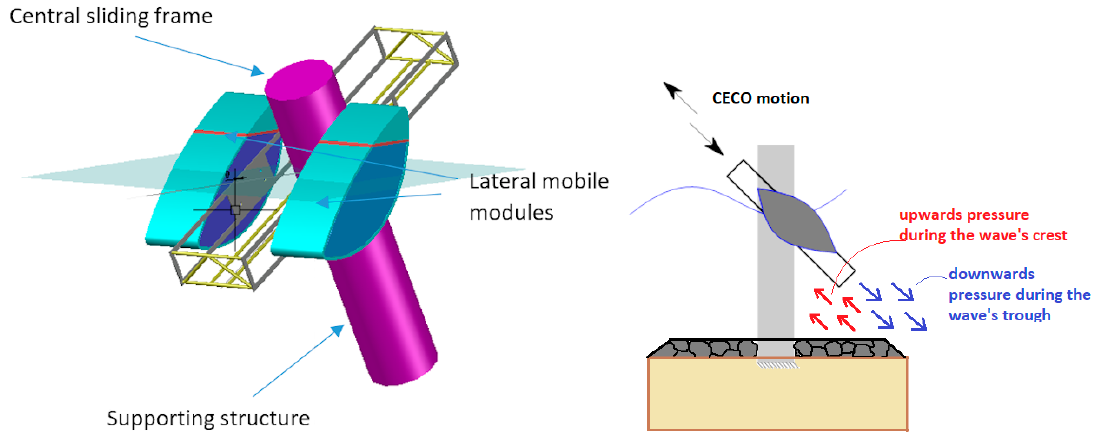
Figure 5. ( Left ): Scheme of CECO device on an oblique monopile support. ( Right ): Scheme of expected upwards and downwards pressure acting on the top layer of the protection.